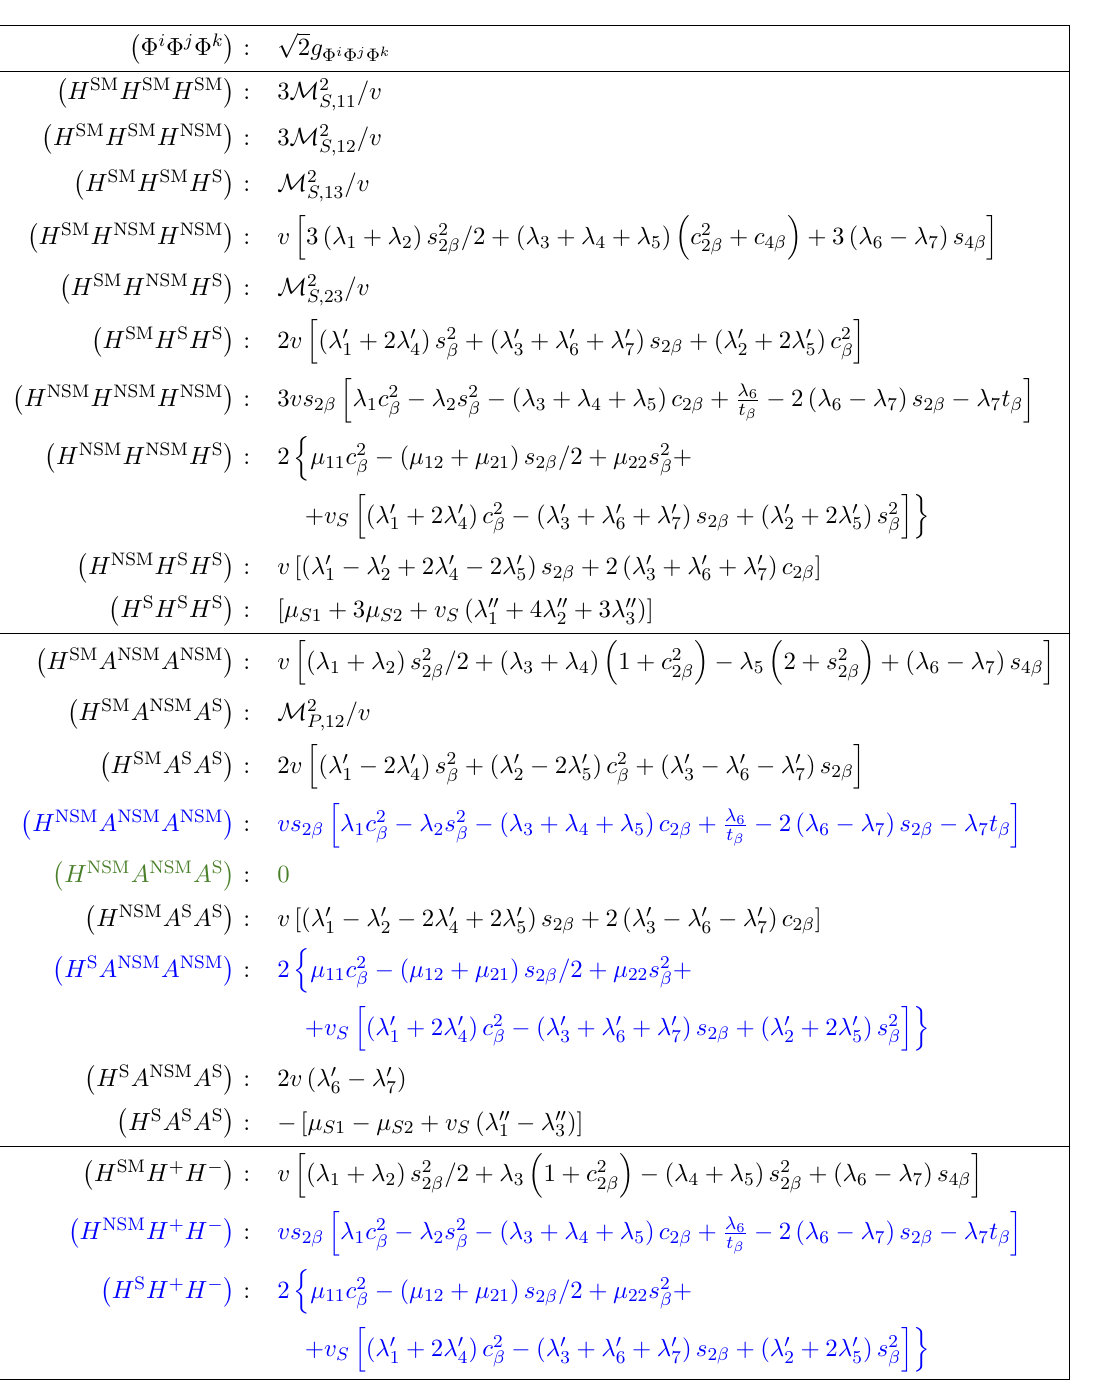
Table 1 . Trilinear couplings in the extended Higgs basis. Note that the coupling between same value as the coupling . Furthermore, the couplings